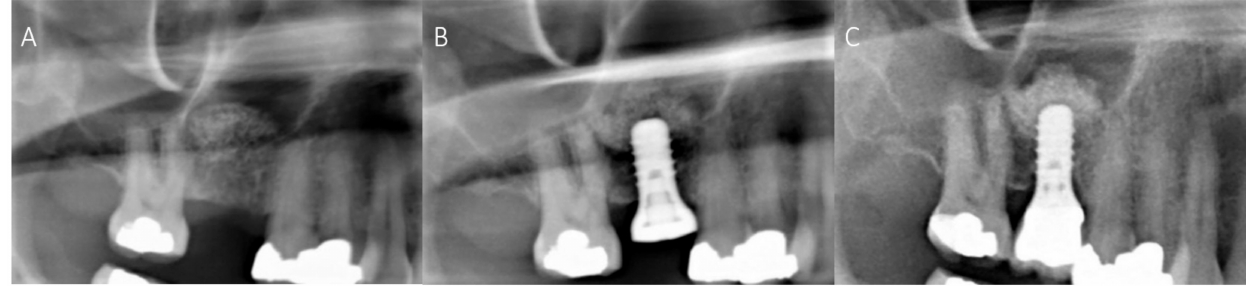
Figure 3. Radiographs of the right partial edentulous maxilla after maxillary sinus floor elevation ( A ), after dental implant placement ( B ) and at 2-year follow-up ( C ). Apical to the dental implant the graft material has been lifted upwards, resulting in a higher local tissue height at the implant